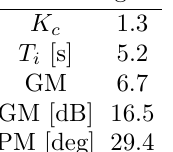
Table 5: Controller settings and performance and ro- bustness measures for simulated PI control system for an ”integrator with two lags” pro- cess with R-ZN tuning with k r =